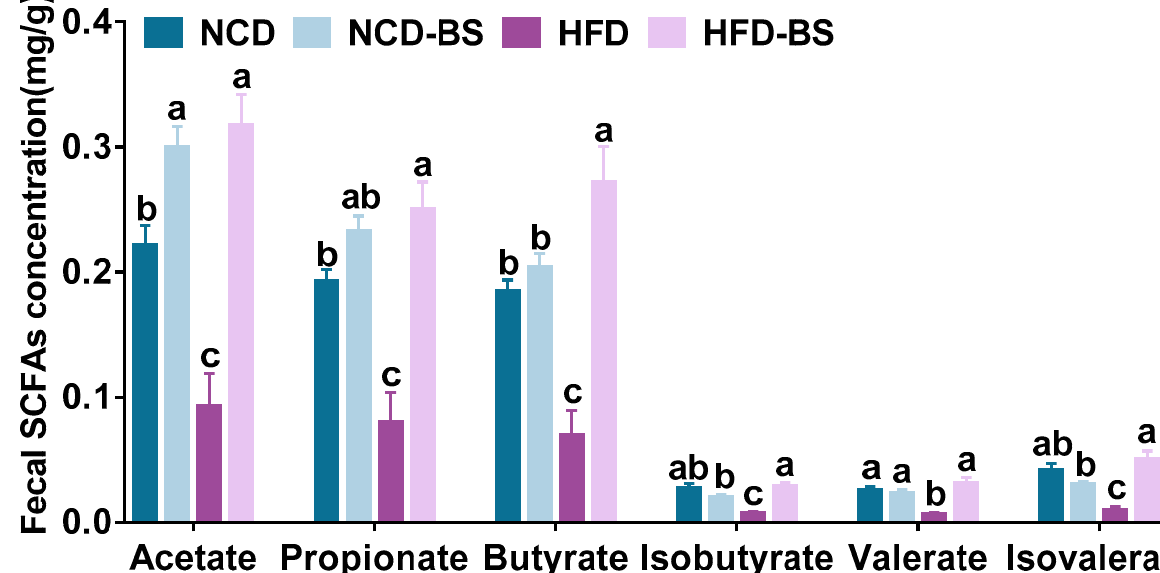
Figure 5. BS promoted the production of SCFAs. n = 6 per group; data are shown as means ± SEM. Means denoted by different letters (a, b, c) indicate significant differences between groups ( p < 0.05). NCD, normal control diet; NCD − BS, normal control diet supplemented with freeze − dried powder of bamboo shoots; HFD, high − fat diet; HFD − BS, high − fat diet supplemented with freeze − dried powder of bamboo shoots.